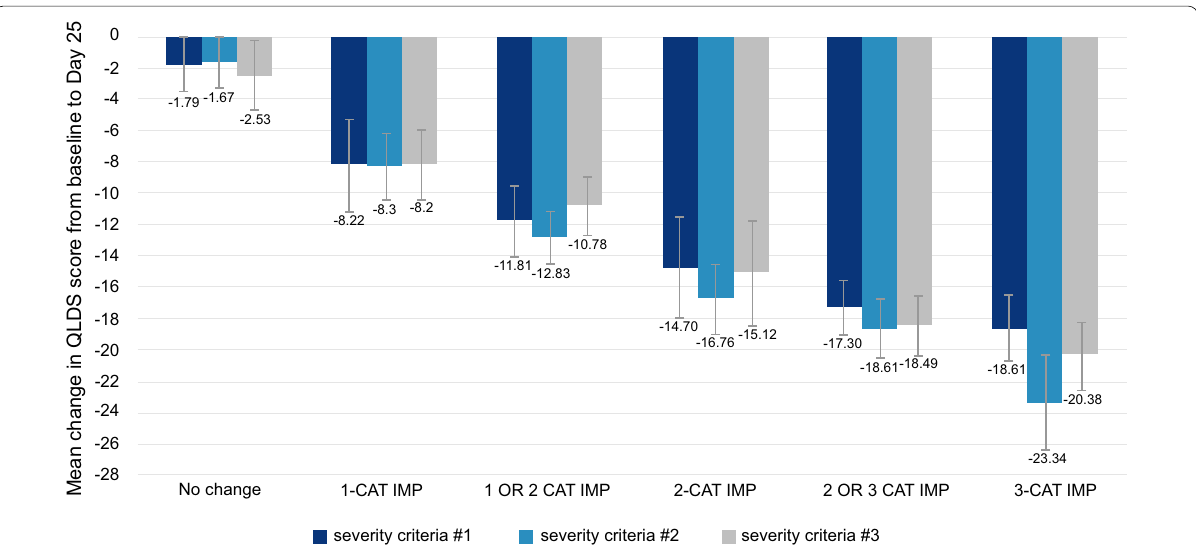
Fig. 1 ASPIRE I–mean change in QLDS score from baseline to Day 25 using MADRS as an anchor. Values are represented as mean was categorized as: severity criteria #1—no depression (score 0–12), slight depression (score 13–21), moderate depression (score 22–28), and severe depression (score > 28–60); severity criteria #2—no depression (score 0–6), mild depression (score 7–19), moderate depression (score 20–34), and severe depression (score > 34–60); and severity criteria #3—no depression (score 0–12), mild depression (score 13–17), moderate depression (score 18–34), and severe depression (score > 34–60). CAT Category, CI Confidence Interval, IMP Improvement, MADRS Montgomery–Åsberg Depression Rating Scale, QLDS Quality of Life in Depression